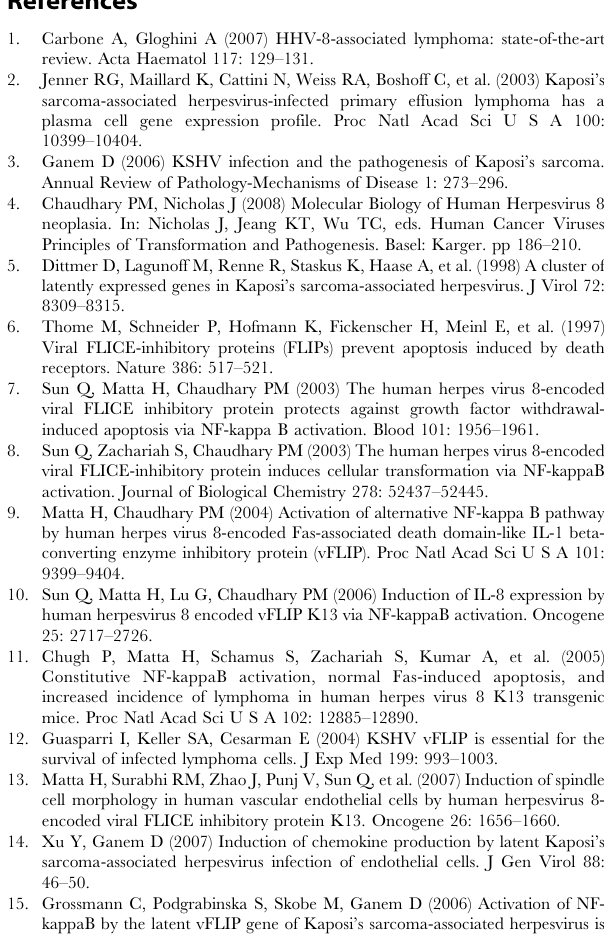
Table S1 List of primers used for qRT-PCR (mRNA expression).